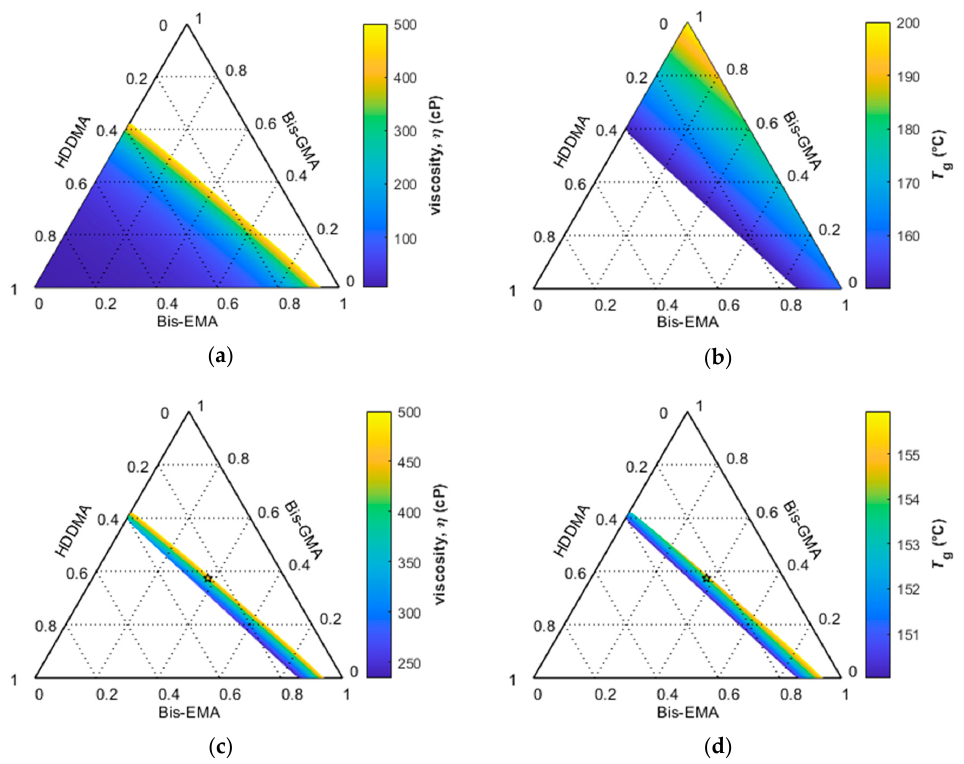
Figure 1. Ternary plots of predicted viscosity and T g as functions of changing composition of Bis-GMA / Bis-EMA / HDDMA system; the axes are weight percentages, and values are represented by color. ( a ) Predicted viscosity lower than 500 cP; ( b ) predicted T g higher than 150 °C; ( c , d ) predicted overlap area where viscosity is lower than 500 cP and T g is higher than 150 °C. The star in ( c , d ) marks the DA-2 composition.